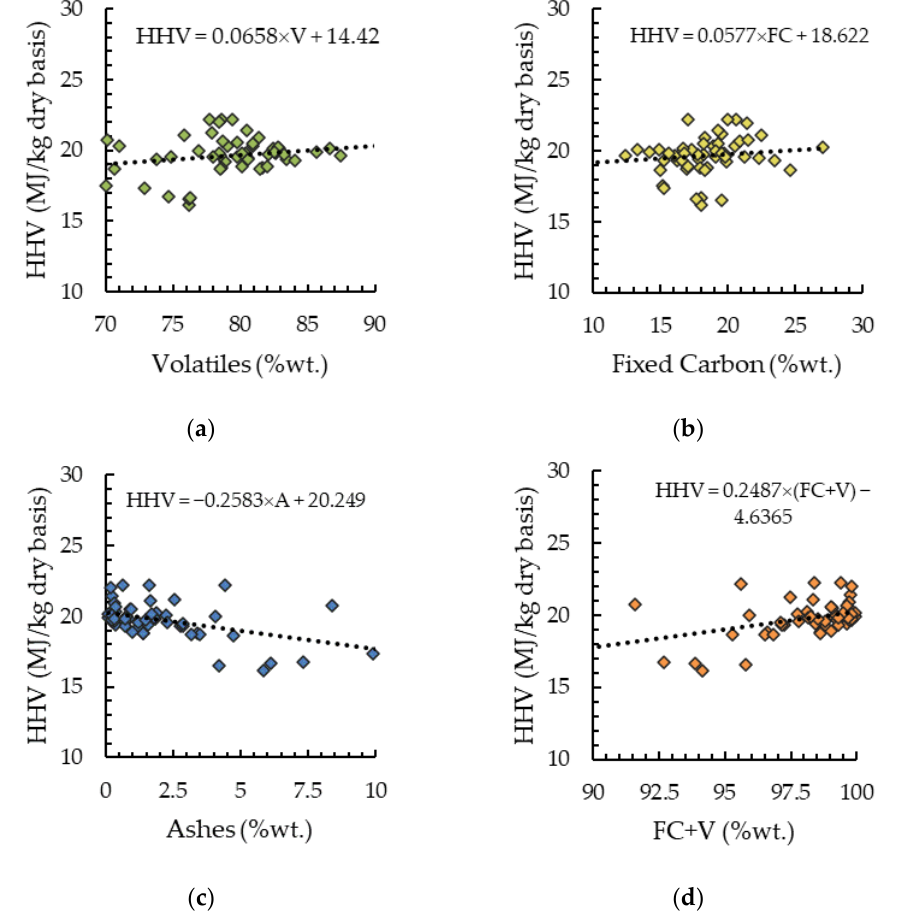
Figure 5. Correlation between HHVs and the independent variables from the proximate analysis on a dry basis: ( a ) volatiles; ( b ) fixed carbon; ( c ) ashes; ( d ) fixed carbon plus volatiles.